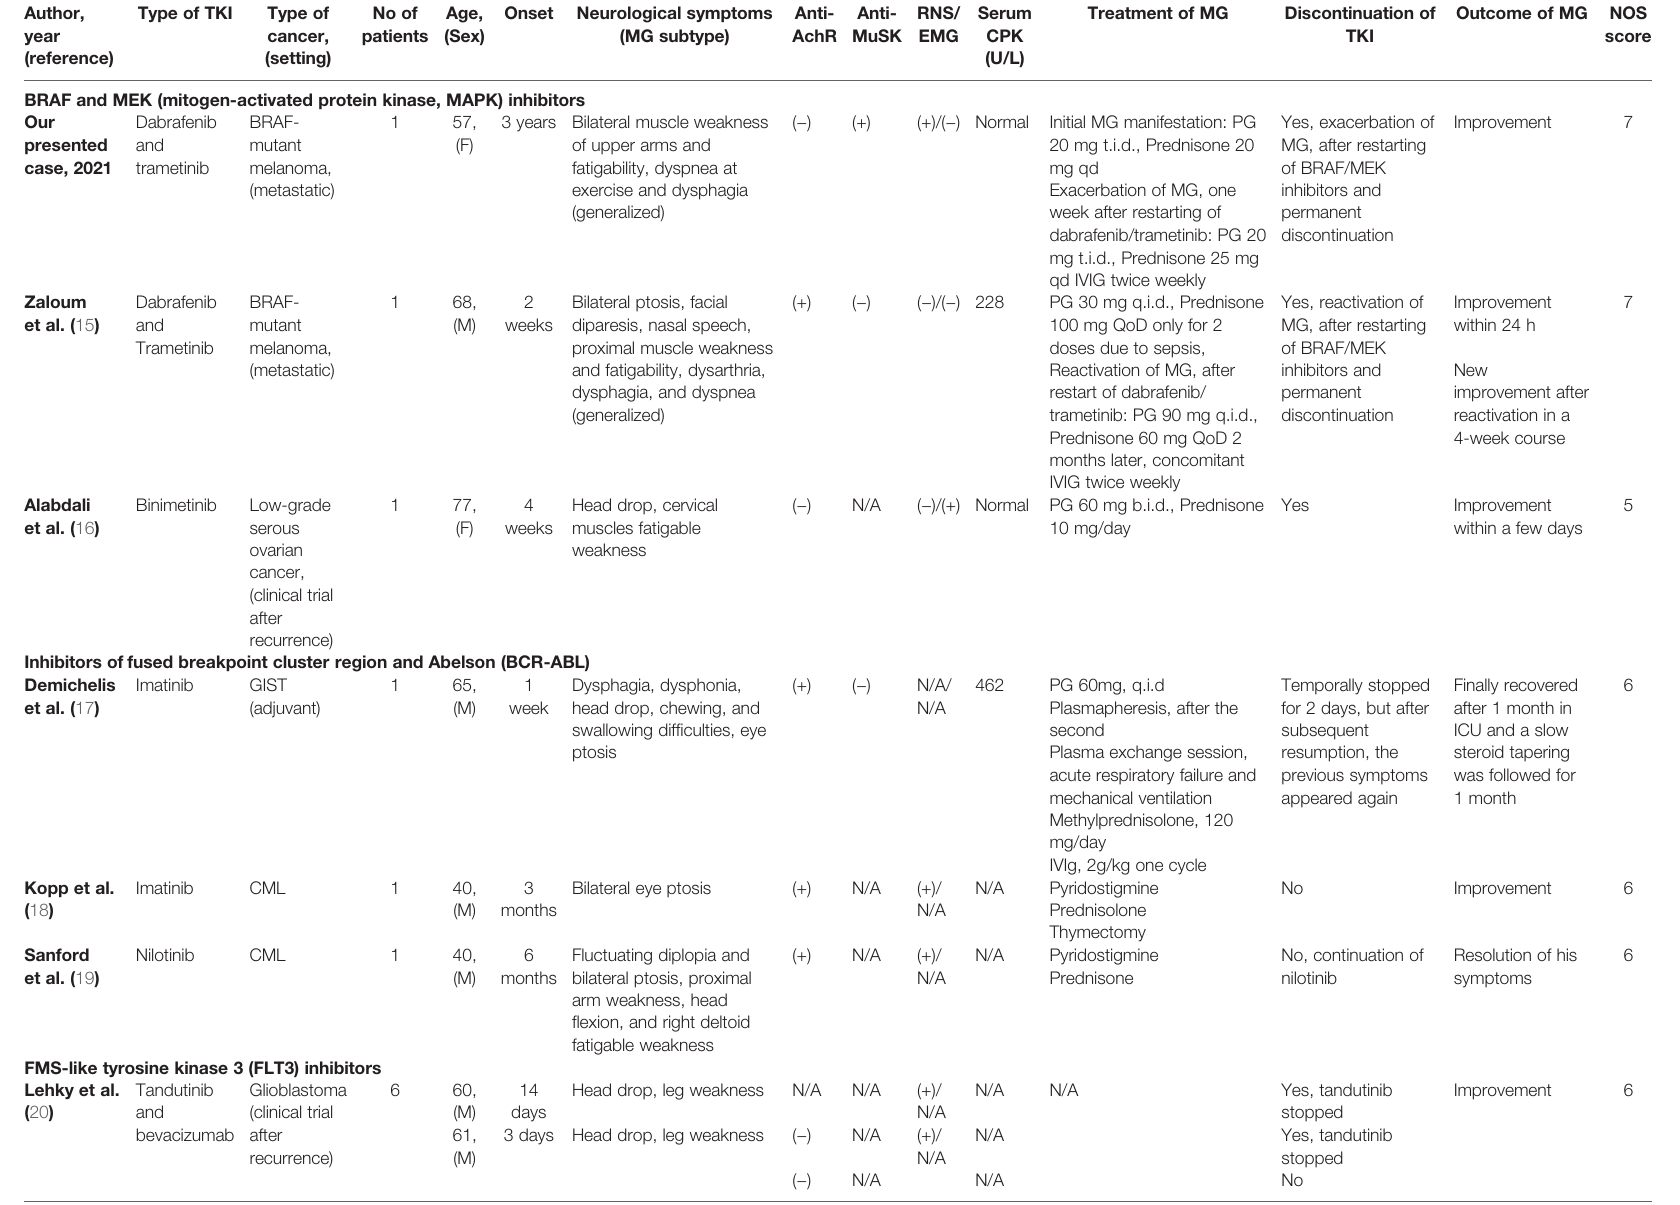
TABLE 1 | Summary of cancer cases that developed seropositive (or not) TKI-induced MG.